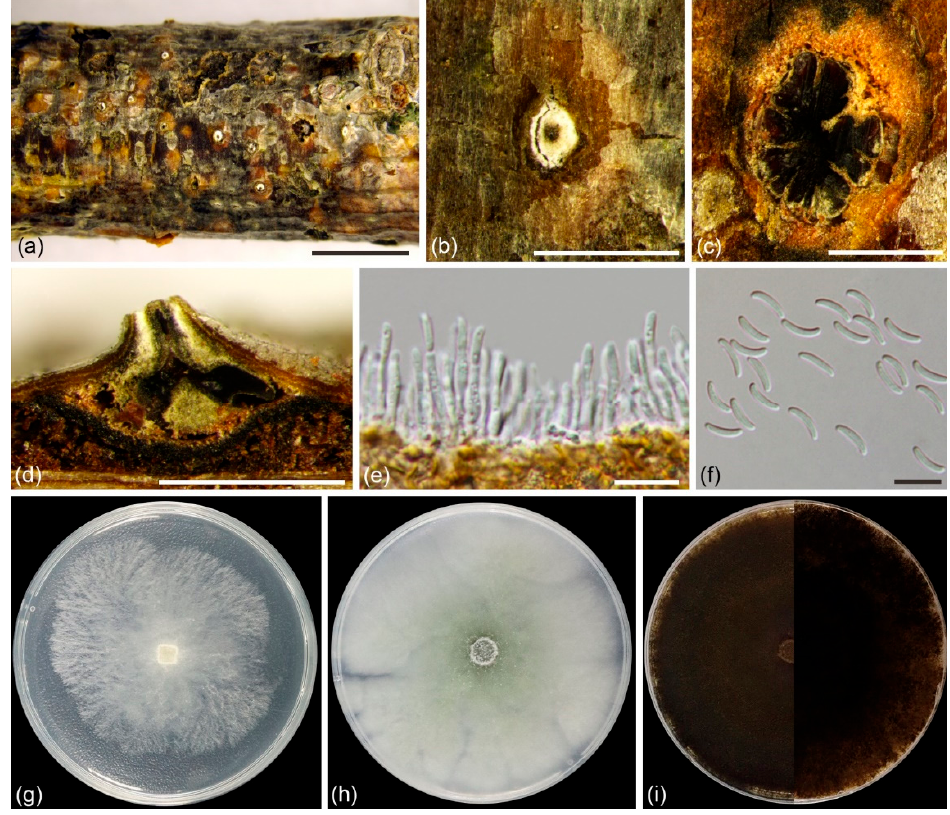
Figure 3. Cytospora alba (BJFC CF20201001) from Salix matsudana : ( a , b ) habit of conidiomata on twig; ( c ) transverse section of conidioma; ( d ) longitudinal section through conidioma; ( e ) conidiophores and conidiogenous cells; ( f ) conidia. Scale bars: 5 mm ( a ); 1 mm ( b – d ); 10 µ m ( e , f ). Cultures on PDA ( g – i , CFCC 55402): ( g ) 2 days; ( h ) 7 days; ( i ) 30 days, front side at left and back side at